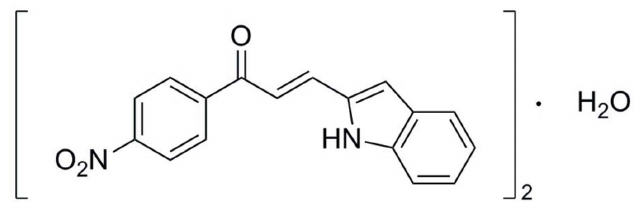
Table 1 Hydrogen-bond geometry (A˚ , (cid:3) ).